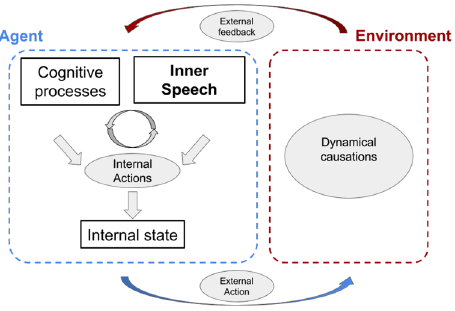
Figure 5. Abstract schema that represents the model double loop of manipulation of internal and external states. The internal manipulation of states allows the agent to better manipulate the external